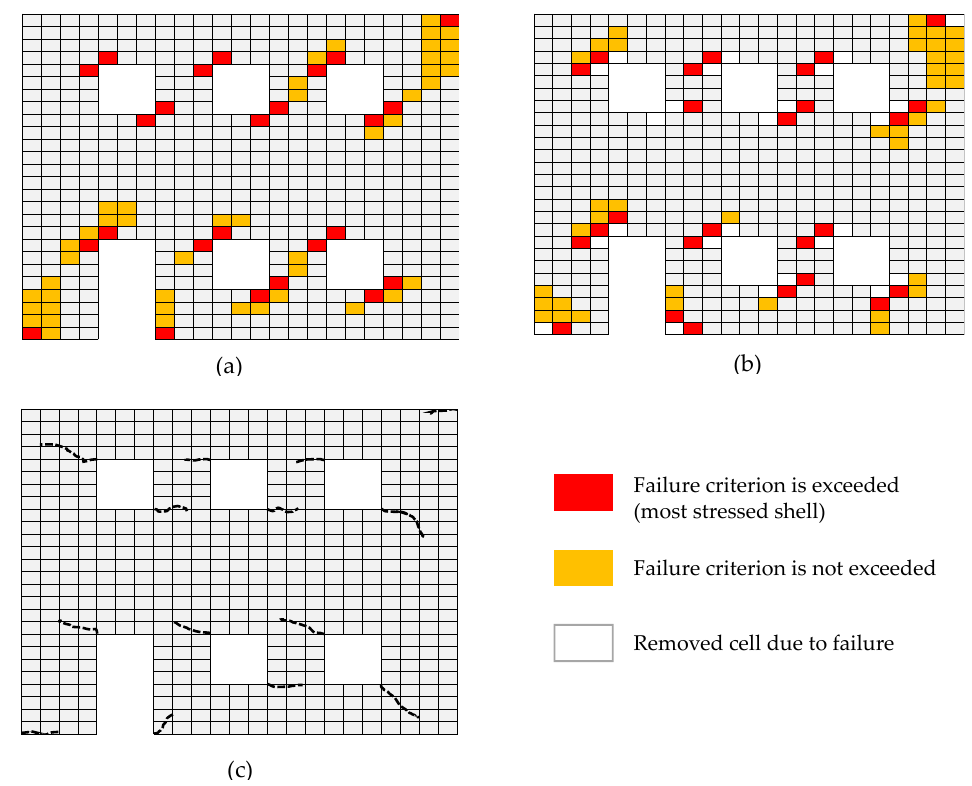
Figure 10. ( a ) Initial stress states at ultimate condition (left), ( b ) first step of crack propagation after removal of overstressed cells (middle), ( c ) the final crack pattern of the considered URM wall (right) [29].